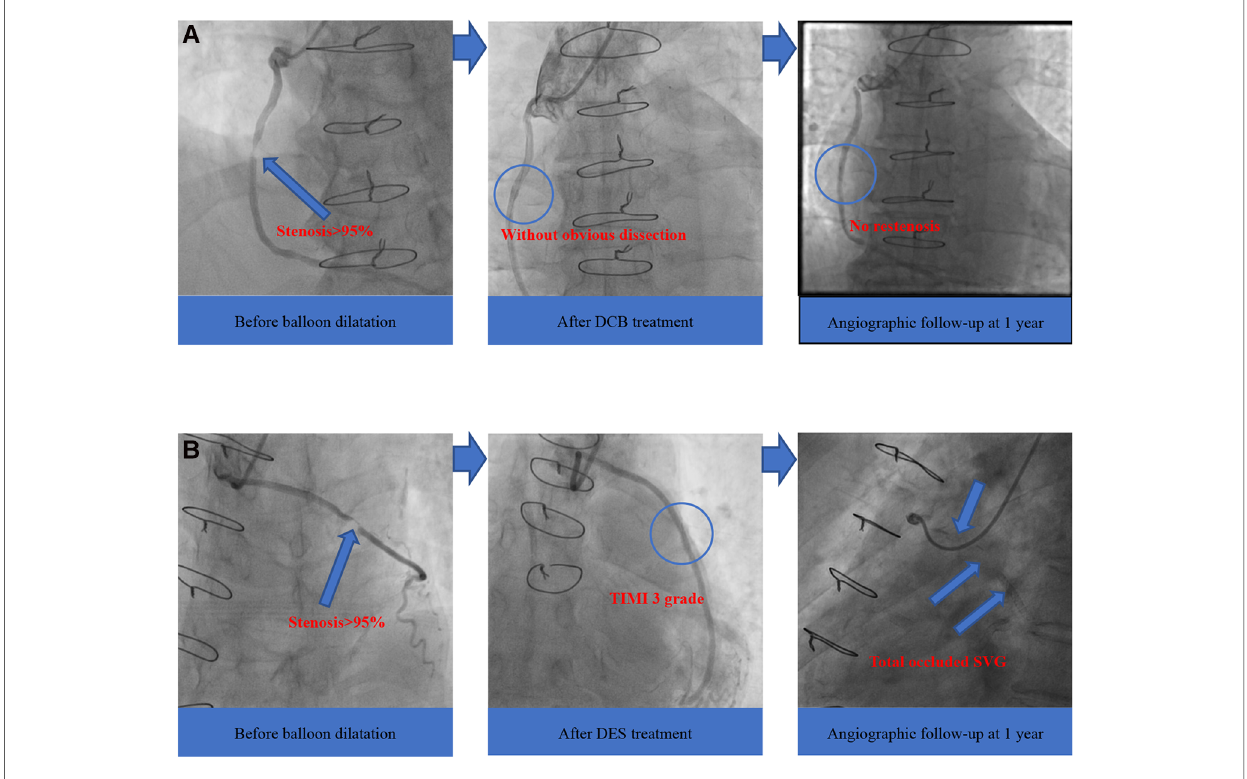
FIGURE 2 Angiographic outcomes of two groups. ( A ) DCB group; ( B ) DES group. DCB, drug-coated balloon; DES, drug-eluting stent; SVG, saphenous vein graft; TIMI, thrombolysis in myocardial